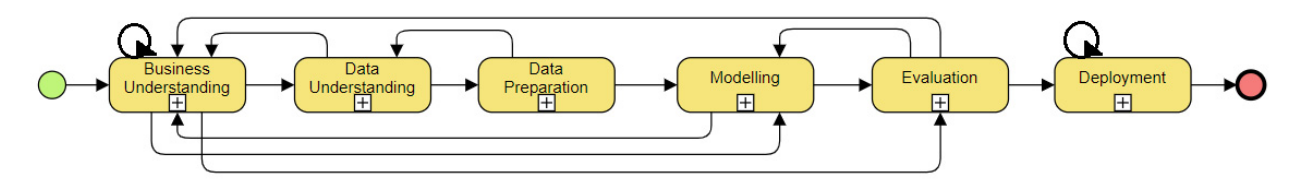
Figure 6. Top diagram proposal for integration of phases.